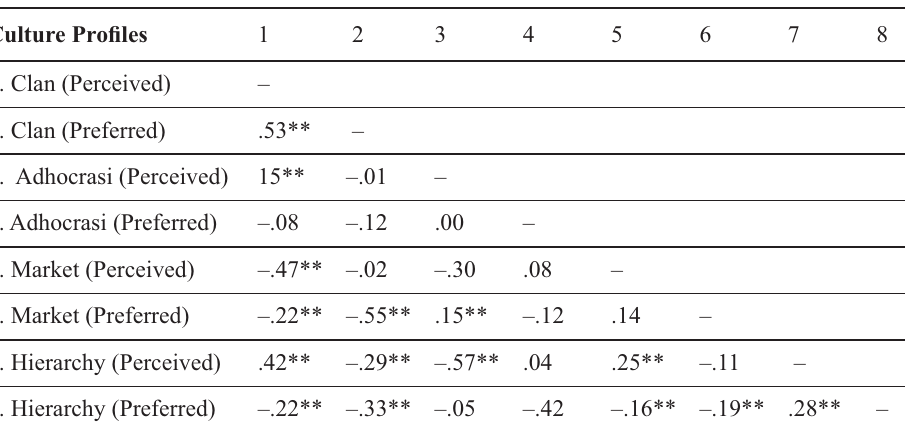
Table 1. Correlation analysis (N = 205; ** p <